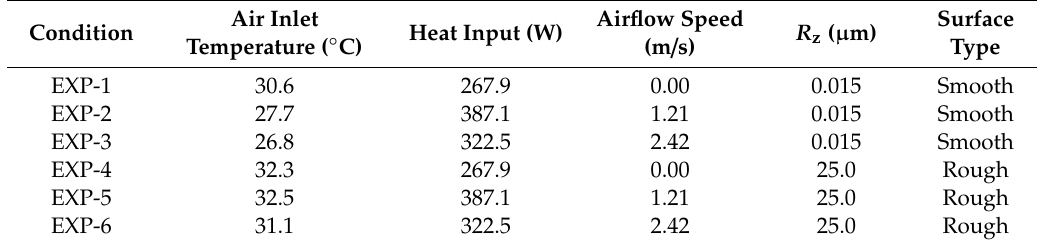
Table 4. The considered conditions of the heat convection